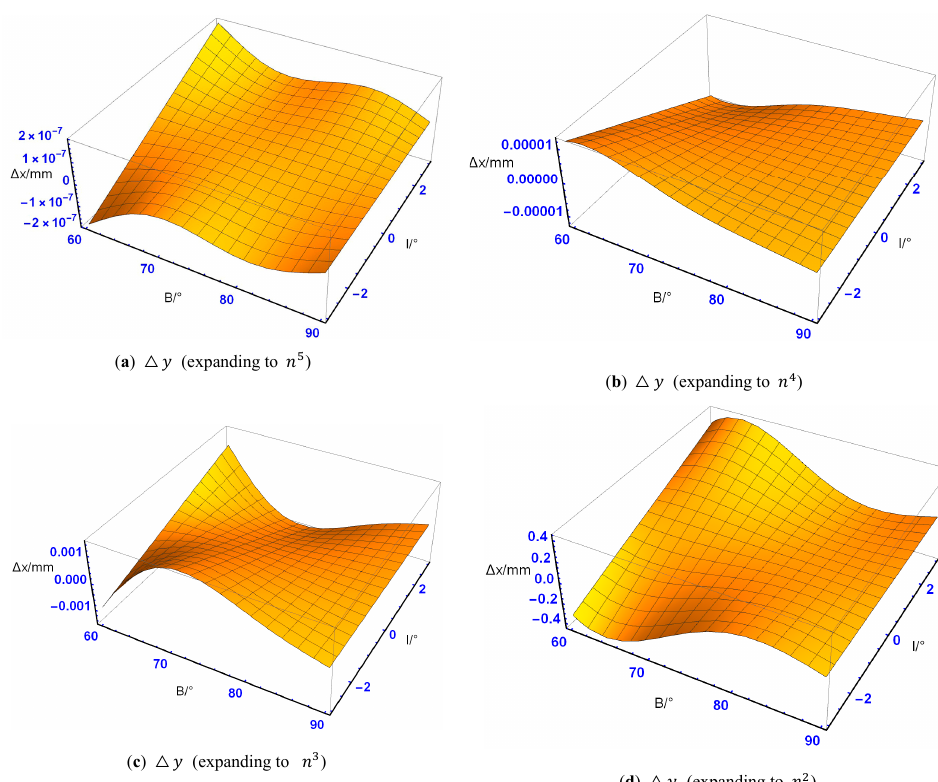
Figure 7. The distribution of the ordinate truncation difference ∆ y when expanding to n 5 , n 4 , n 3 , and n 2 .